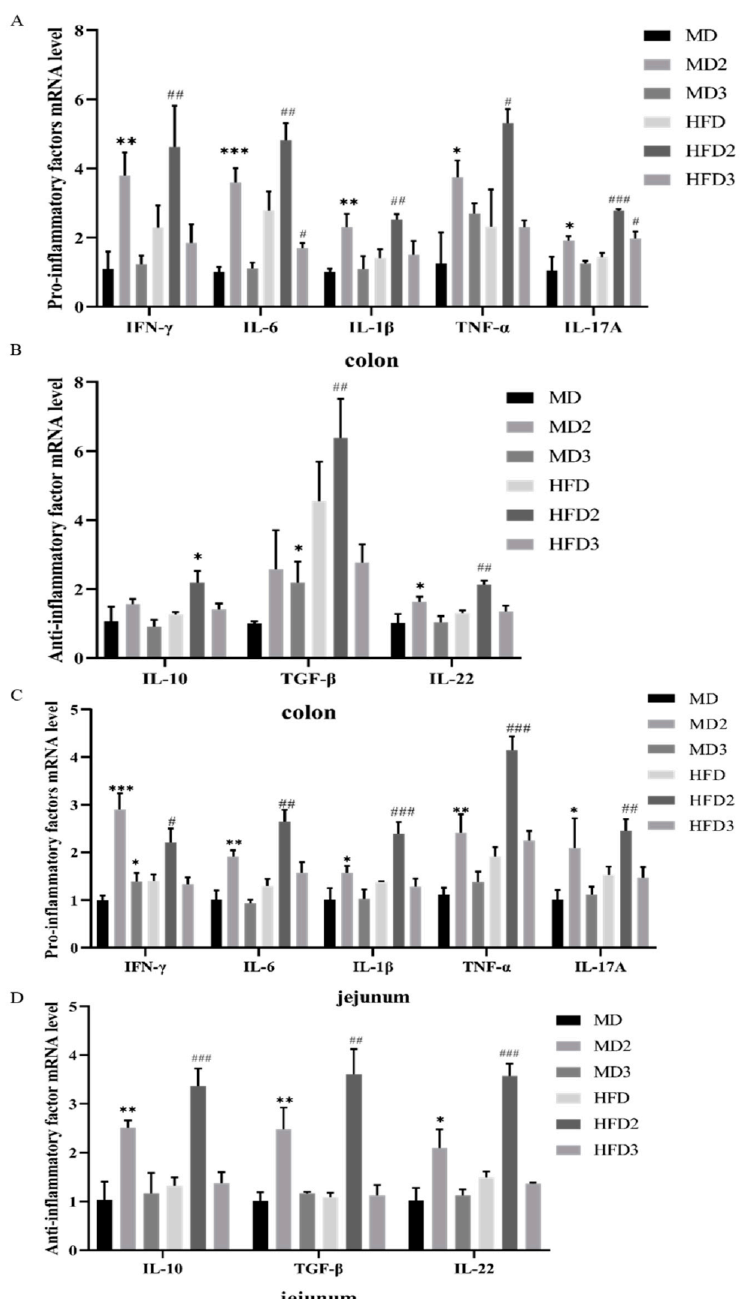
Figure 4. L. plantarum 1201 recovers the expression disorder of inflammatory factors caused by S. Typhimurium ATCC 13311. ( A ) mRNA expression levels of pro-inflammatory factors in mouse colon; ( B ) mRNA expression levels of anti-inflammatory factor in mouse colon; ( C ) mRNA ex- pression levels of pro-inflammatory factors in mouse jejunum; ( D ) mRNA expression levels of anti-inflammatory factors in mouse jejunum. * p < 0.05; ** p < 0.01; *** p < 0.001; # p < 0.05; ## p < 0.01; ### p < 0.001; * is compared with MD, # is compared with HFD; paired two-tailed t-test. MD: normal diet; MD2: normal diet and 1 × 10 8 CFU/mL S. Typhimurium ATCC 13311; MD3: normal diet, 1 × 10 8 CFU/mL S. Typhimurium ATCC 13311 and 1 × 10 8 CFU/mL L. plantarum 1201; HFD: HFD; HFD2: HFD and 1 × 10 8 CFU/mL S. Typhimurium ATCC 13311; HFD3: HFD, 1 × 10 8 CFU/mL S. Typhimurium ATCC 13311 and 1 × 10 8 CFU/mL L. plantarum